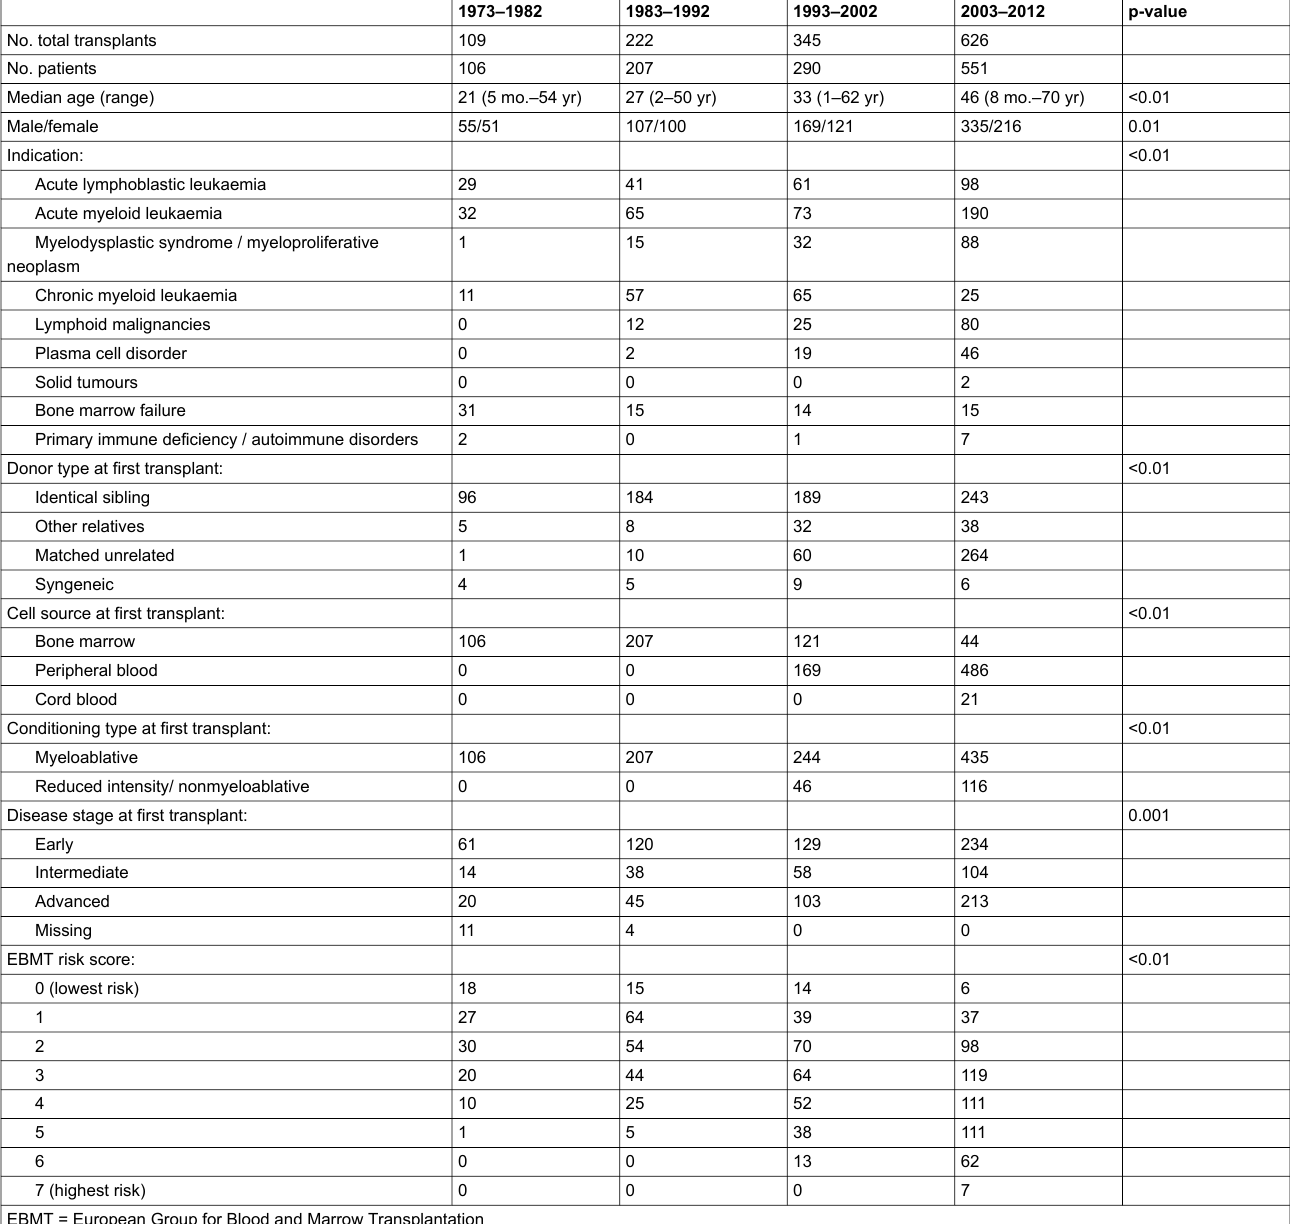
Table 1: Allogeneic haematopoietic stem cell transplantation ‒ patient and first transplant characteristics per